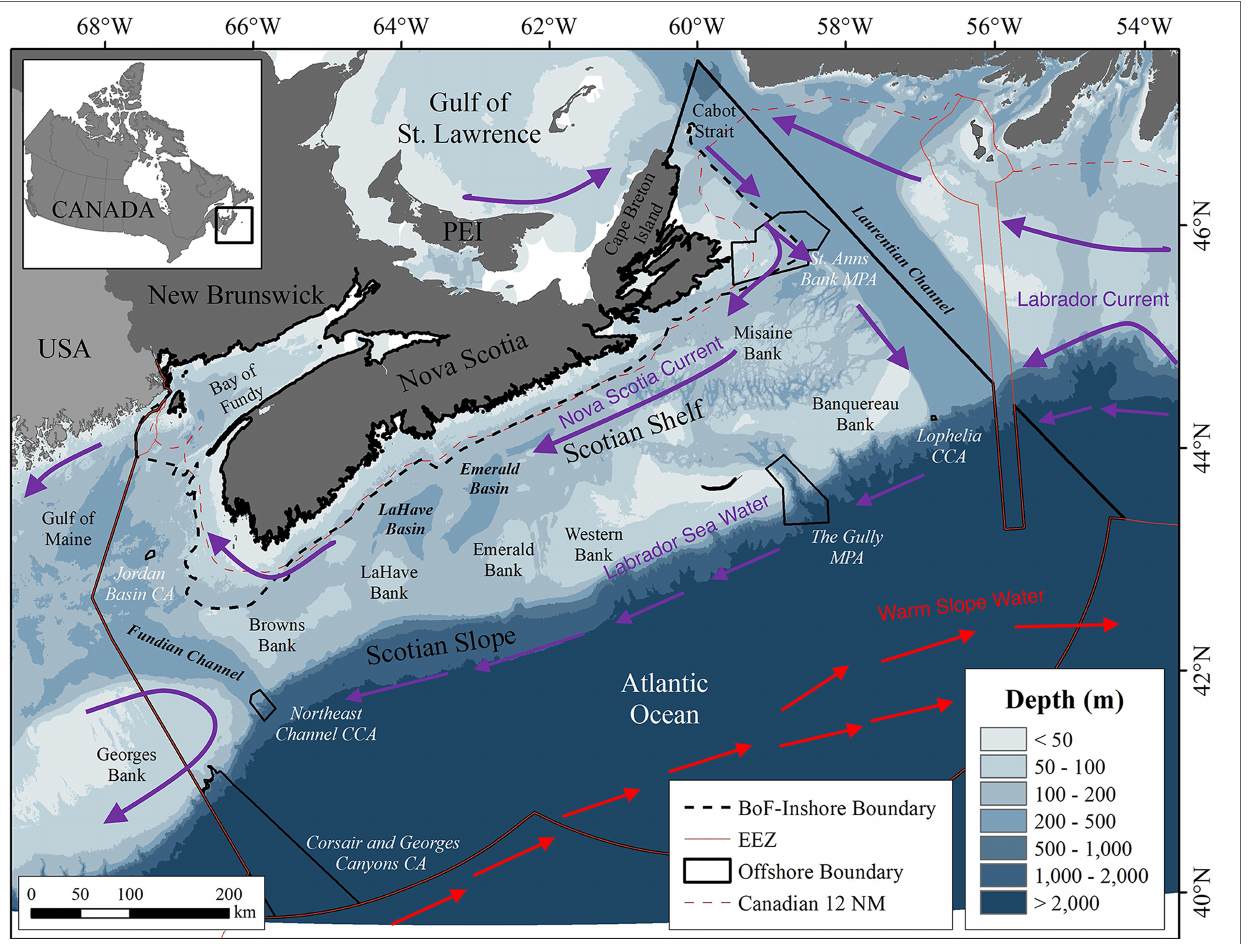
FIGURE 2 | Place names and locations of features in the Scotian Shelf bioregion study area (black perimeter). The six conservation areas within the study area but outside the 12 nm Territorial Sea (dashed line) are shown in black outline with their names in white lettering. The general location of currents and water masses influencing the region are indicated. CA, Conservation Area; CCA, Coral Conservation Area; MPA, Marine Protected